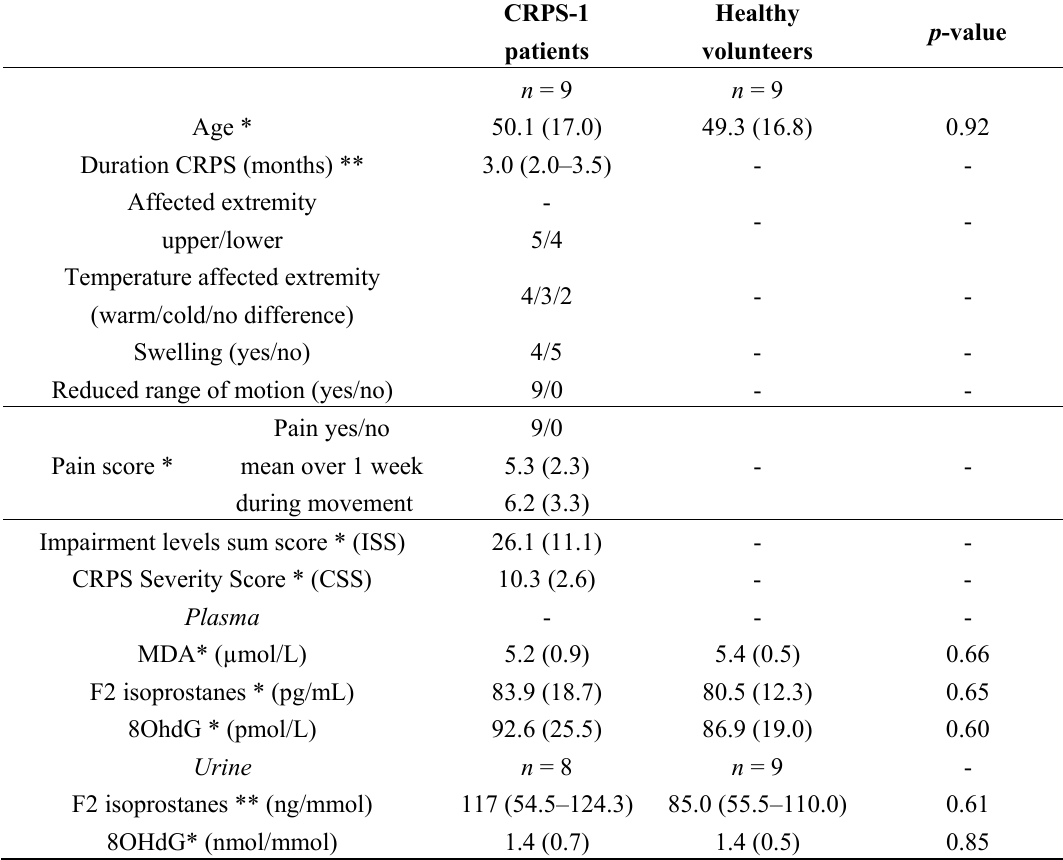
Table 1. Characteristic and markers of oxidative stress of Complex Regional Pain Syndrome (CRPS)-1 patients and healthy volunteers.